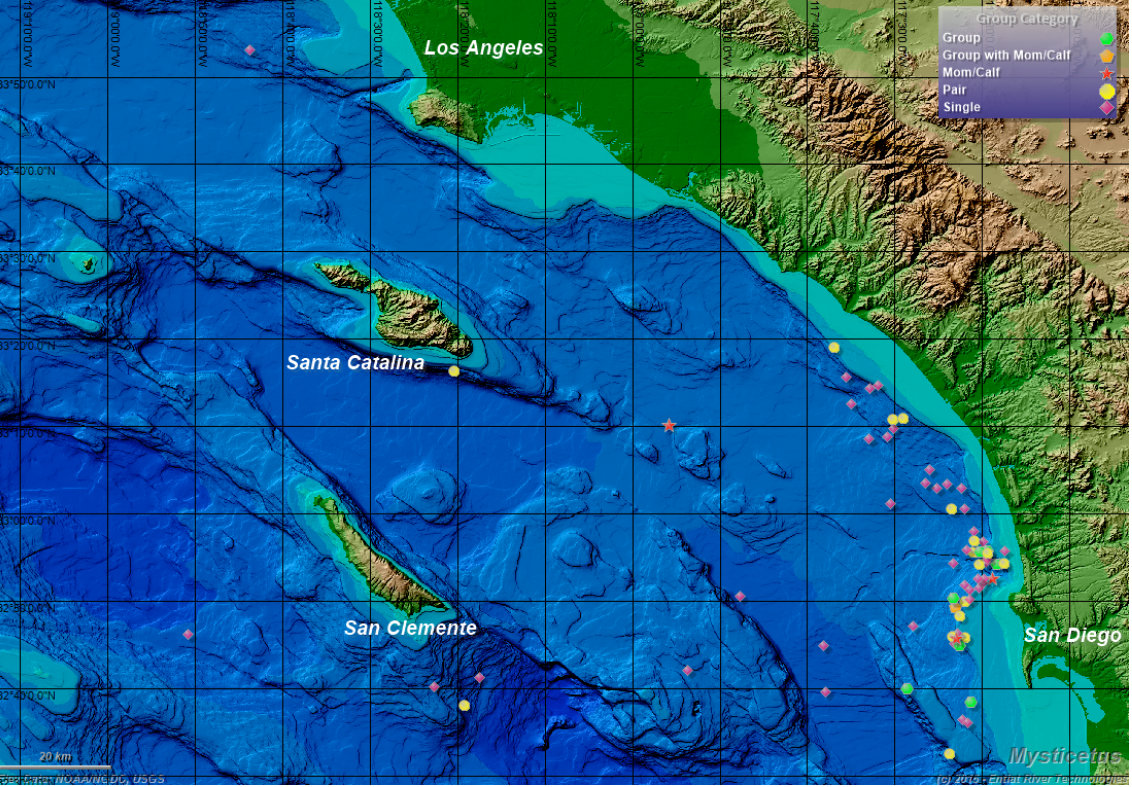
Figure 2. Map of all blue whale sightings during all months in the Southern California Bight study area 2008 - 2013. Group Type